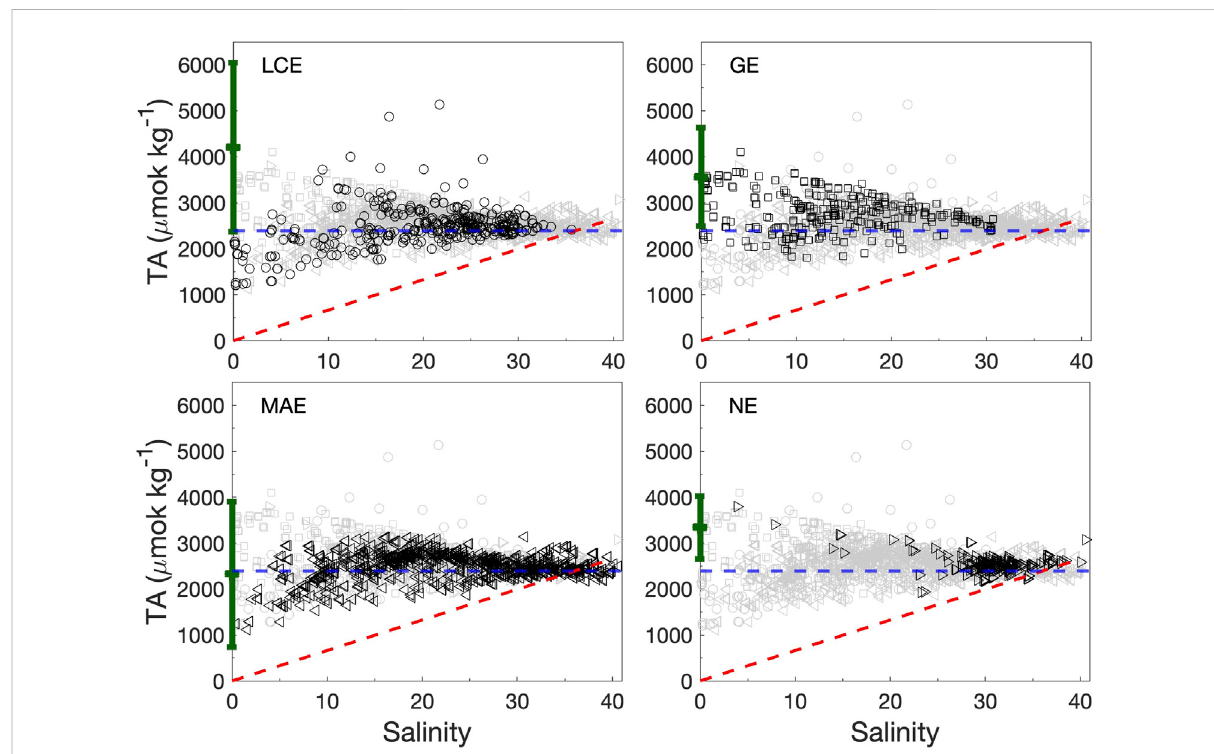
FIGURE 4 TA vs. salinity in the four studied estuaries during 2014 – 2018. Data from each estuary are shown in black symbols against the entire dataset (gray). The green error bar in each panel represents the river endmember value (±1 standard deviation) for the corresponding estuary (Yao et al., 2022). The horizontal dashed line (blue) represents the open ocean TA value (2,390 μ mol kg − 1 at salinity 36) (Hu et al., 2018). The red dashed line represents the precipitation-evaporation line based on the ocean endmember